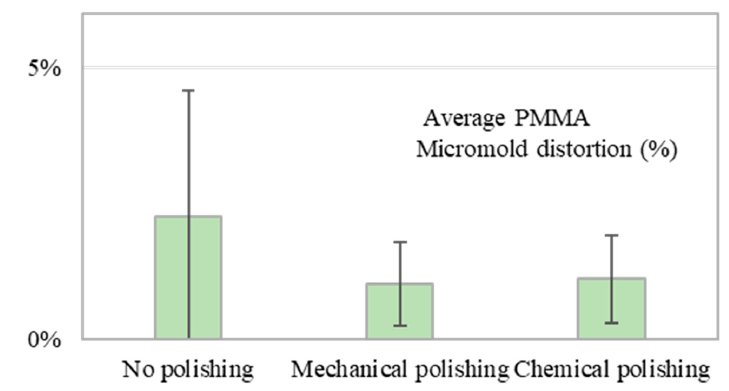
Figure10. PMMAmicromolddistortionpercentageforPDMScastinginno-polish, mechanicalpolishing, Figure 10. PMMA micromold distortion percentage for PDMS casting in no-polish, mechanical andchemicalpolishingconditions. Theerrorbarswereobtainedbasedonfiveindividualmeasurements. polishing, and chemical polishing conditions. The error bars were obtained based on five individual measurements.